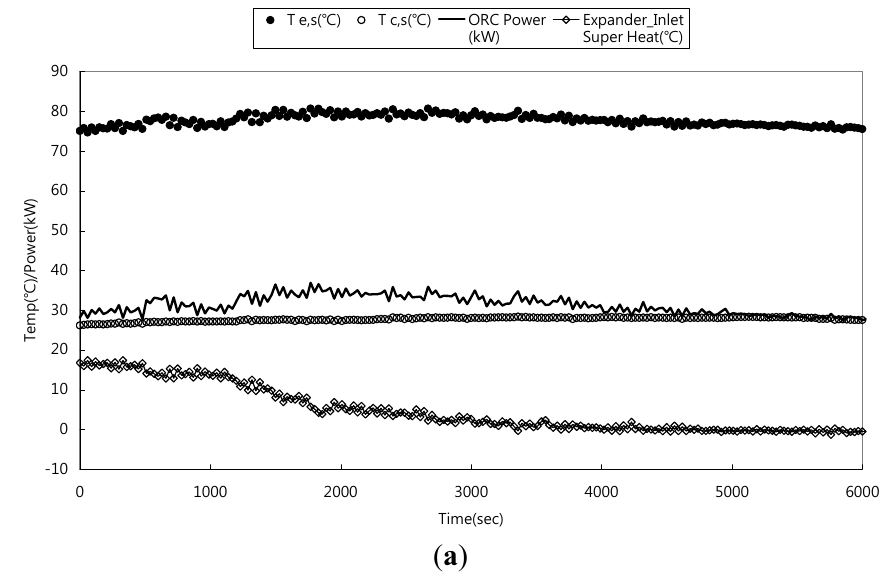
Figure 6. System response of the 50 kW ORC system with the shell-and-tube evaporator subject to an exit superheat of 0–17 °C. ( a ) Response of temperatures; : evaporator temperature, T : condenser ( b ) Response of pressures. ( T e,s c,s